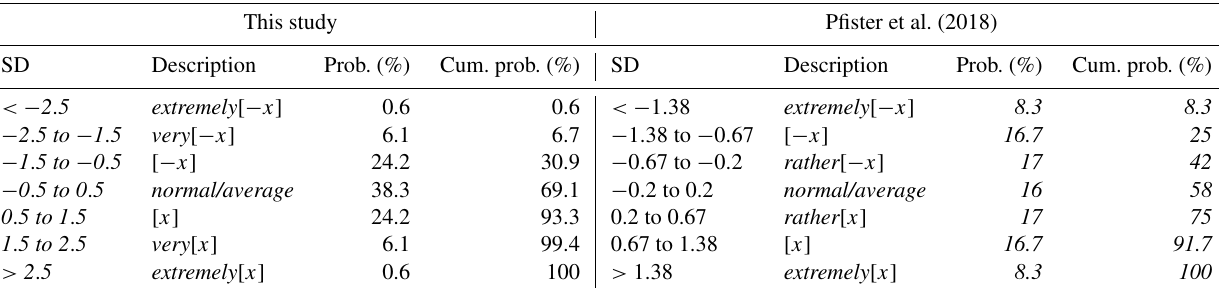
Table 3. Seven-point scale for indexing standardised anomalies (SD), description ( x denotes a property and − x its reverse, e.g. “warm” and “cold”, “wet” and “dry”, or “late” and “early”) and corresponding probabilities (prob.) and cumulative probabilities (cum. prob.) for (left part of table) this study and (right) (Pfister et al., 2018). Italics: thresholds and descriptions that are part of the definition; other columns are implied by assuming a normal distribution.